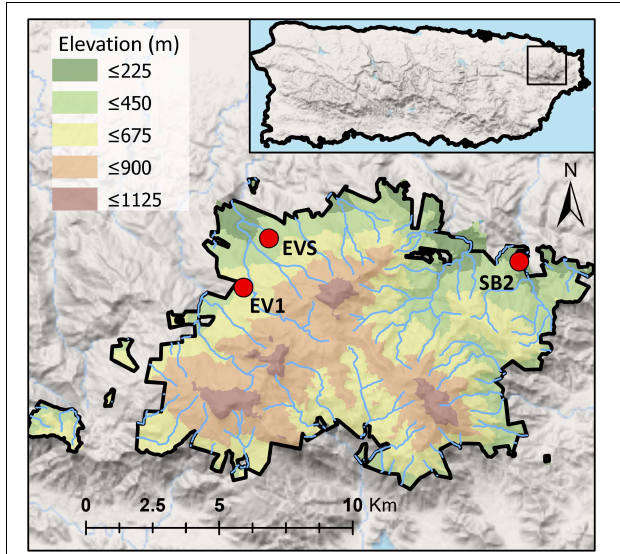
FIGURE 1 | Map of the Luquillo Experimental Forest (LEF)—Puerto Rico, with the location of the studied sited (red circles). Two sites (EV1 and EVS) were located near El Verde Field Station, and one site (SB2) was located near the USDA Forest Service Sabana Field Research